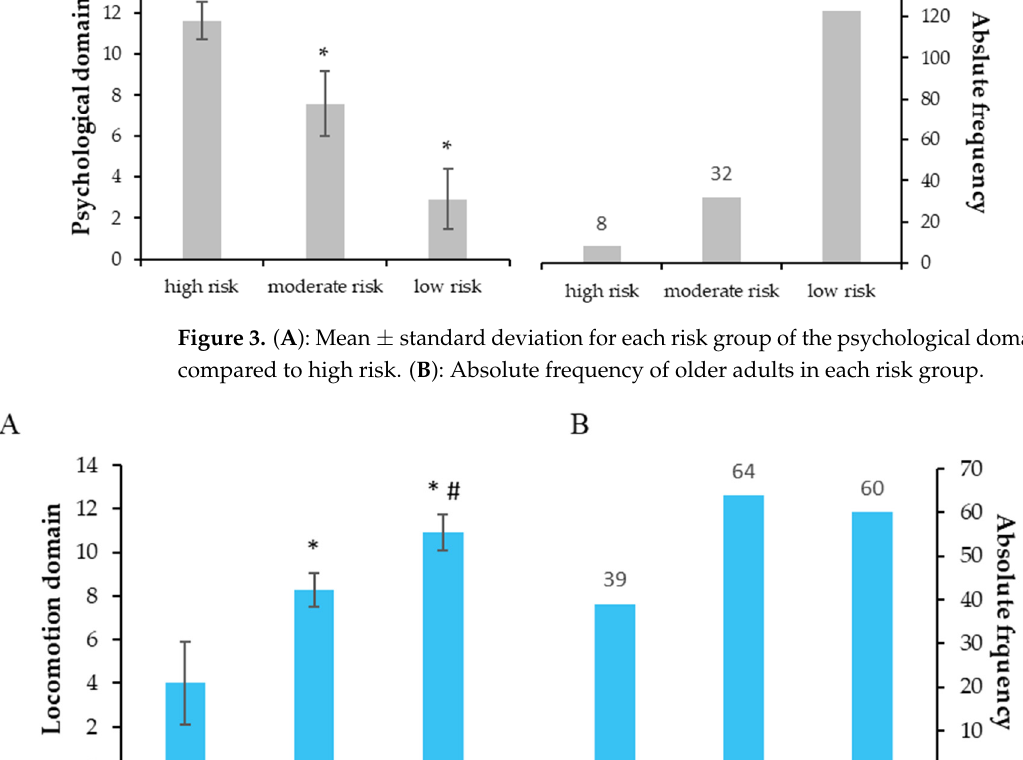
Figure 3. ( A ): Mean ± standard deviation for each risk group of the psychological domain. * p < 0.001 compared to high risk. ( B ): Absolute frequency of older adults in each risk group.